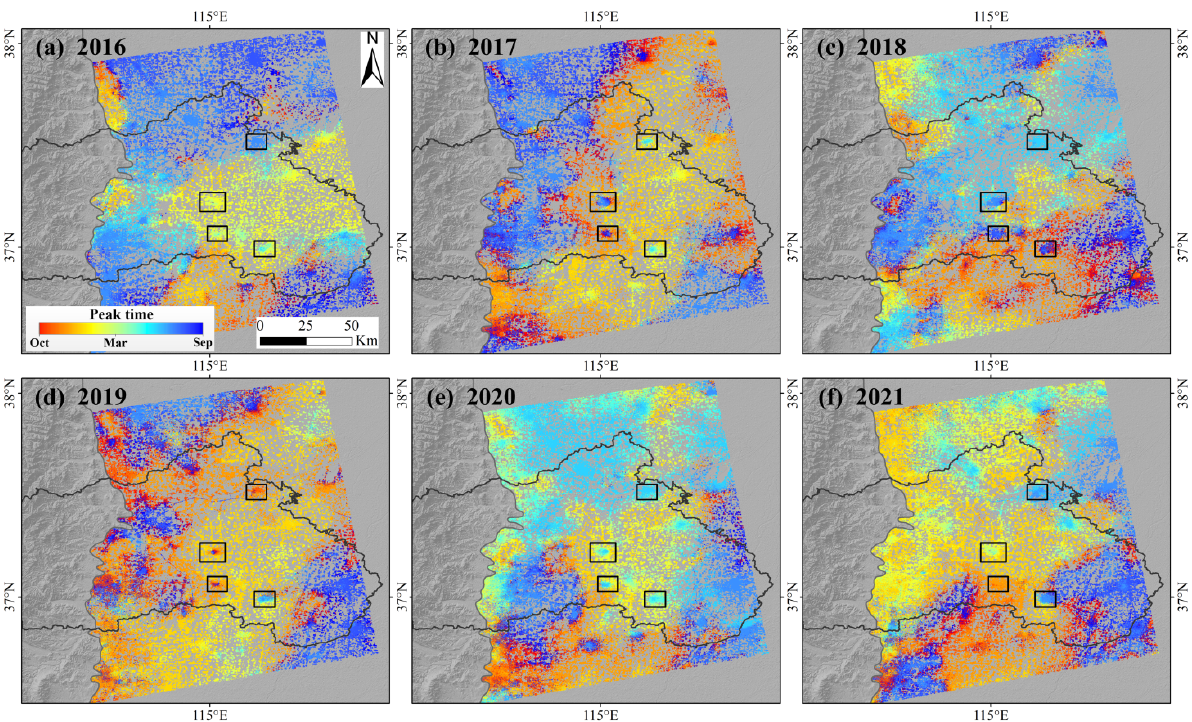
Figure 8. The peak time of seasonal deformation across the Xingtai plain in ( a – f ) 2016~2021. The black boxes mark the county’s urban areas. boxes mark the county’s urban